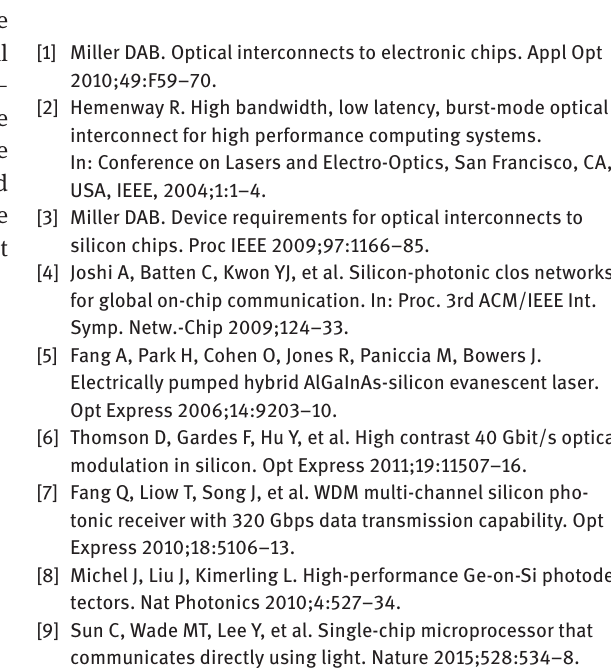
Figure 7: Dynamic response of the optical switching